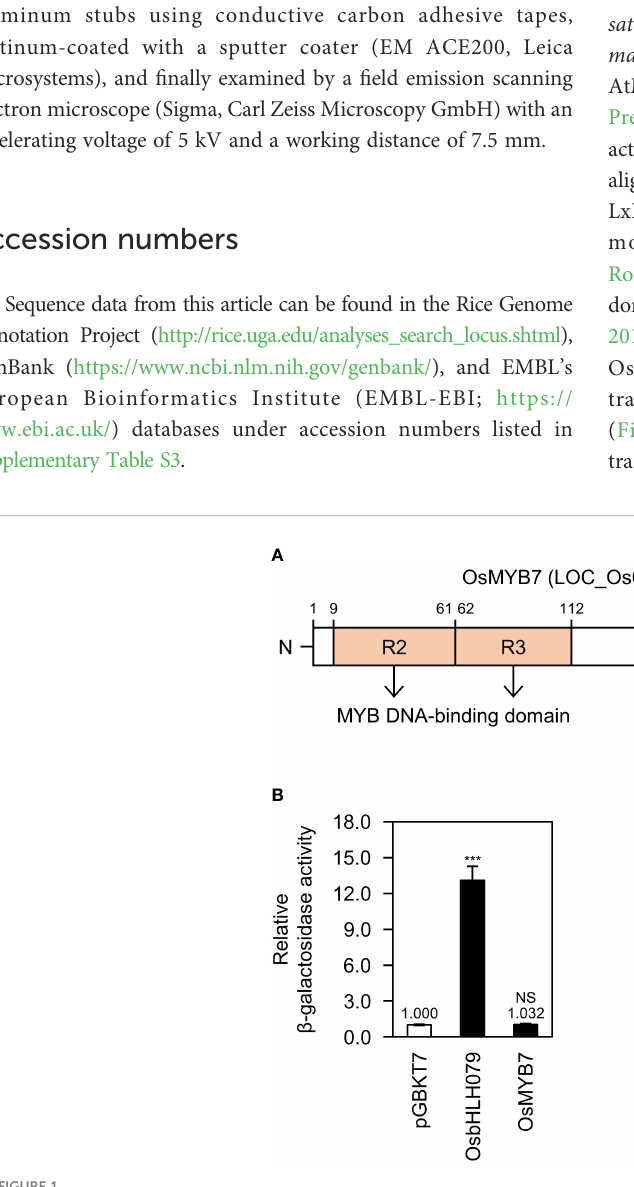
FIGURE 1 Biochemical characterization of OsMYB7. (A) Schematic diagram of the OsMYB7 protein. The two pale orange boxes indicate the highly conserved R2 and R3 MYB repeats. OsMYB7 also harbors an LxLxL-type EAR transcriptional repression motif, shown by the blue box. EAR, ethylene-responsive element binding factor-associated amphiphilic repression. (B) Transactivation activity assay of OsMYB7 in yeast. The full-length coding sequence of OsMYB7 cloned in the vector pGBKT7 was subjected to a quantitative b -galactosidase liquid assay: OsbHLH079 was used as a positive control, and pGBKT7 was used as a negative control. The b -galactosidase activity of each sample was normalized relative to that of the negative control, which was set to 1. Data are presented as means ± standard deviation (SD) from four independent yeast colonies. Signi fi cant differences between means were determined using two-tailed Student ’ s t -test (*** P < 0.001). This experiment was performed twice with similar results. NS, not signi fi cant. (C) Trans-repression activity assay of OsMYB7 in yeast. The full-length coding sequence of OsMYB7 cloned in the vector rGAL4 was subjected to a quantitative b -galactosidase liquid assay: ONAC026 was used as a positive control, and rGAL4 was used as a negative control. The b -galactosidase activity of each sample was normalized to that of the negative control, which was set to 1. Data are presented as means ± SD of four independent yeast colonies. Asterisks indicate signi fi cant differences as determined by two-tailed Student ’ s t -test (*** P < 0.001). This experiment was conducted twice yielding similar results. NS, not signi fi